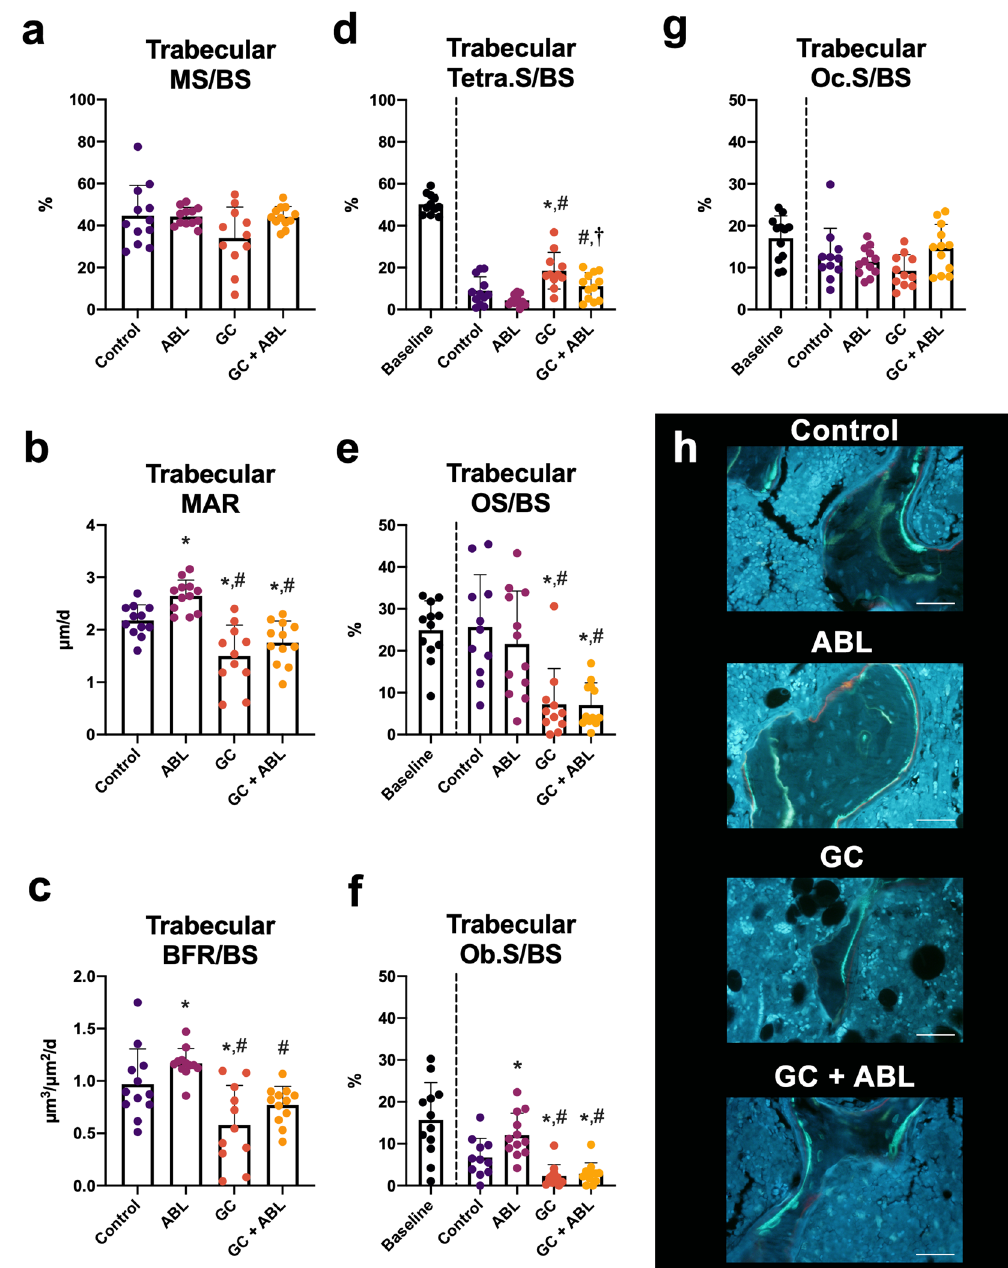
Figure 4. Distal femoral metaphyseal trabecular bone parameters determined by dynamic bone histomorphometry and histological assessment of osteoid, osteoblasts, and osteoclasts. ( a ) MS/BS: mineralizing surface, ( b ) MAR: mineral apposition rate, ( c ) BFR/BS: bone formation rate, ( d ) Tetra.S/BS: tetracycline-covered surfaces, ( e ) OS/BS: osteoid-covered surfaces, ( f ) Ob.S/BS: osteoblast-covered surfaces, ( g ) Oc.S/BS: osteoclast- covered surfaces, and ( h ) Representative histological sections from the four treatment groups. Bar = 50 μm. Mean ± SD. An interaction was found between treatment with ABL and GC for Ob.S/BS ( p = 0.045) and Oc.S/BS ( p = 0.027). * p < 0.05 vs. Control. # p < 0.05 vs. ABL. † p < 0.05 vs. lower MS/BS (− 68%) and MAR (− 69%) compared with Control indicating that GC inhibited bone formation at the endocortical bone surface. An interaction between treatment with ABL and GC was found for Tetra.S/BS. The lower Tetra.S/BS indicated that endocortical bone resorption was elevated in GC + ABL-treated mice compared with Control, ABL, and GC mice (Fig. 5).